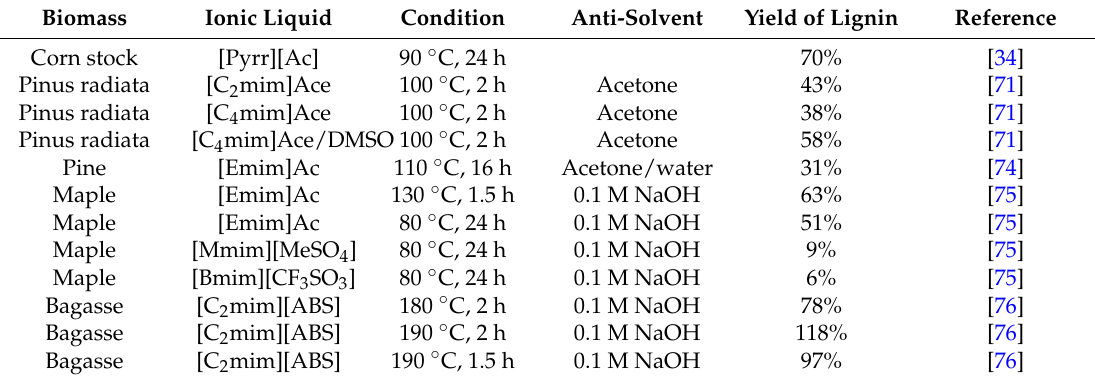
Table 3. Separation and recovery of lignin from biomass using ILs and IL-based solvent systems.